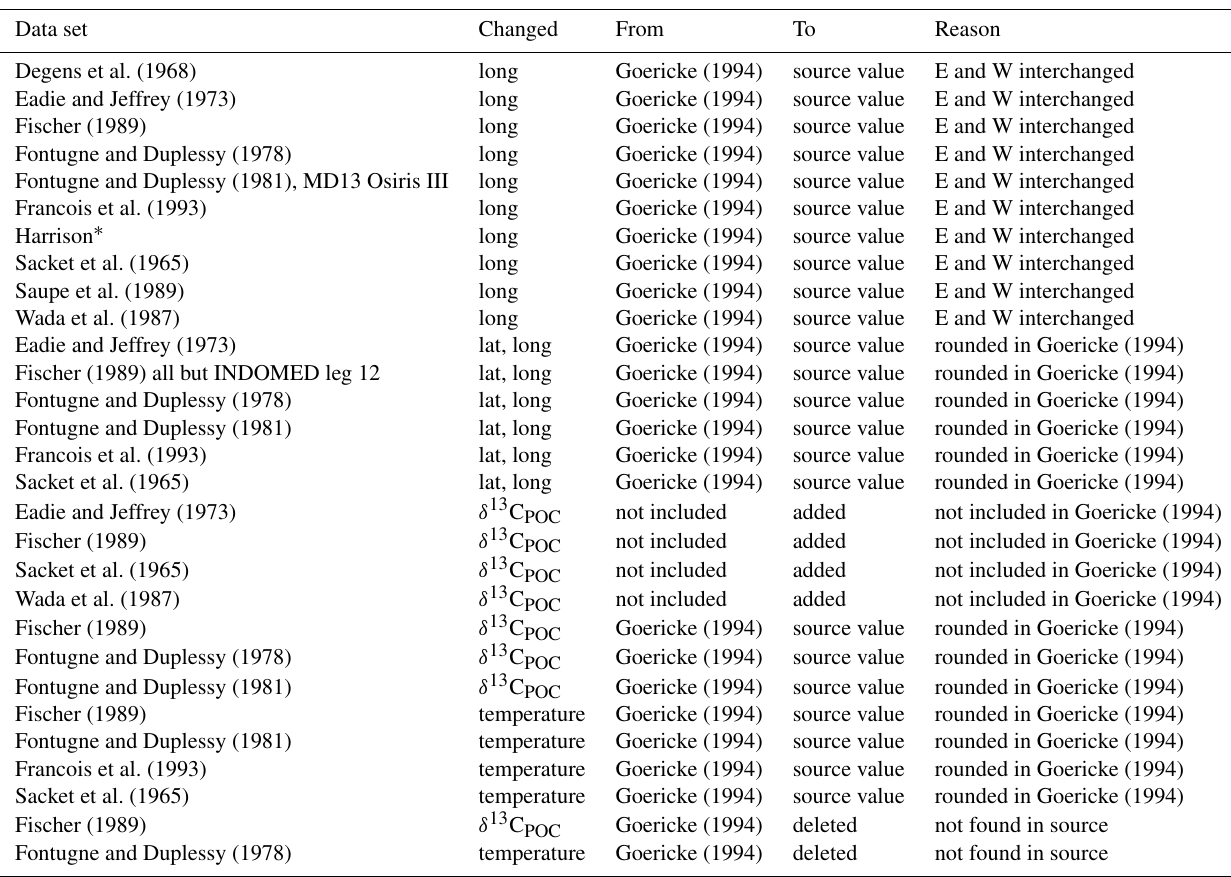
Table 1. Changes that were introduced into data taken from Goericke (1994): the first column names the publication or author of the primary data set. The second column lists in which part of the data we applied changes. The third and fourth columns show what these changes were, and the last column gives the reason for this.